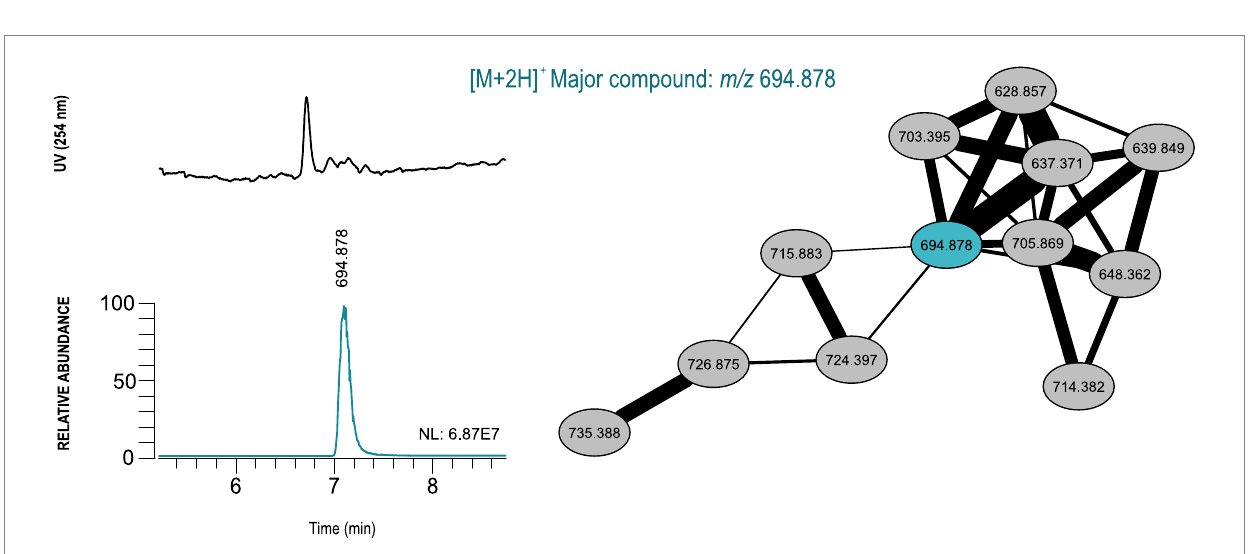
FIGURE 6 GNPS-based LC-HRESIMS/MS molecular networking analysis of the actinobacterial crude extract from Microbacterium sp. DS3_6.1, retrieved from the Arctic region, which probably contains news natural products. Unique molecular cluster represented by connected ellipses and marked with the corresponding m/z value. The major compound is estimated from the UV chromatogram and EICs, and shown in a different color from the remaining cluster nodes. The NL (normalization level) value corresponds to the base peak intensity of the m/z value when compared with the mass composition of the actinobacterial crude